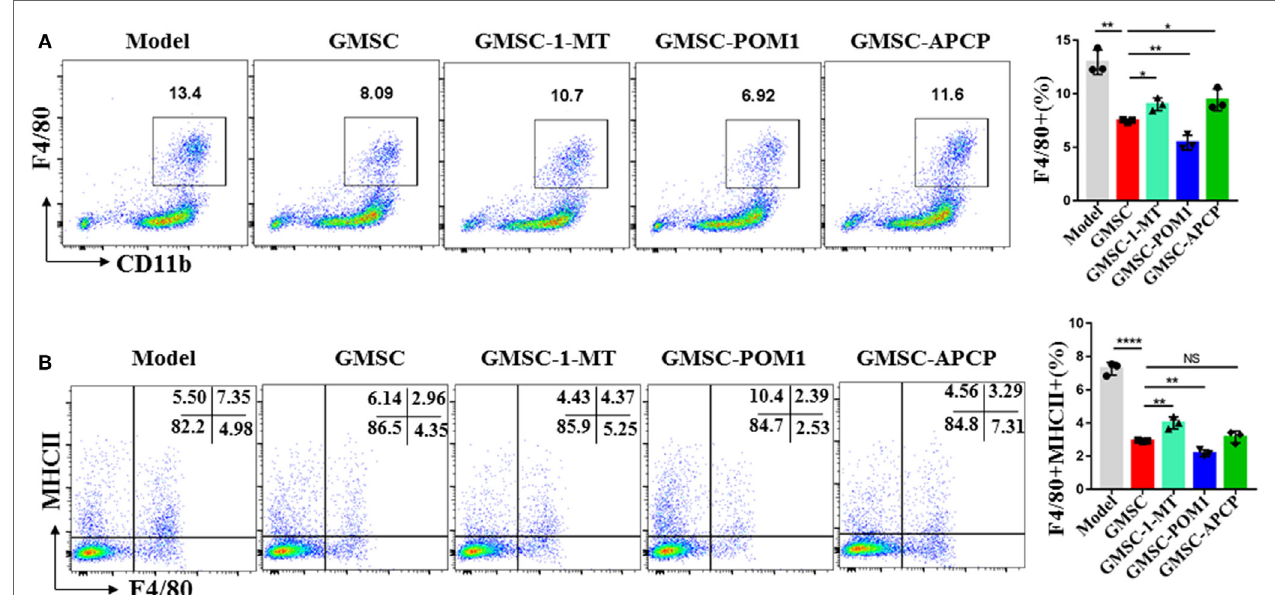
FigUre 6 | Human gingiva-derived mesenchymal stem cells (GMSC) modulate the differentiation of macrophages partly via CD73 and IDO signals. GMSC were pre-treated with α , β -methylene ADP (APCP, 100 µM), or sodium polyoxotungstate 1 (POM1, 100 µM) overnight and washed with complete medium. CD11b + monocytes isolated from bone marrow of C57BL/6 mice and CD11b + cells purified using magnetic isolation (Miltenyi Biotec) (purity: > 95%) were added to co-cultured with GMSC with or without l -1-methyltryptophan (1-MT, 500 µM), co-cultured with GMSC, pretreated with POM1 or APCP in the presence of LPS(100 ng/mL) for 48 h, then suspending cells were collected and stained with fluorochrome-conjugated antibodies specific for mouse MHCII and F4/80 followed by analyzing with flow cytometry. (a) Representative dot plots of F4/80 + were depicted. (B) Representative dot plots of F4/80 + MHCII + were depicted. Bar graphs show the mean ± SD, n = 3. * p < 0.05; ** p < 0.01; *** p < 0.001; **** p < 0.0001; NS, p >